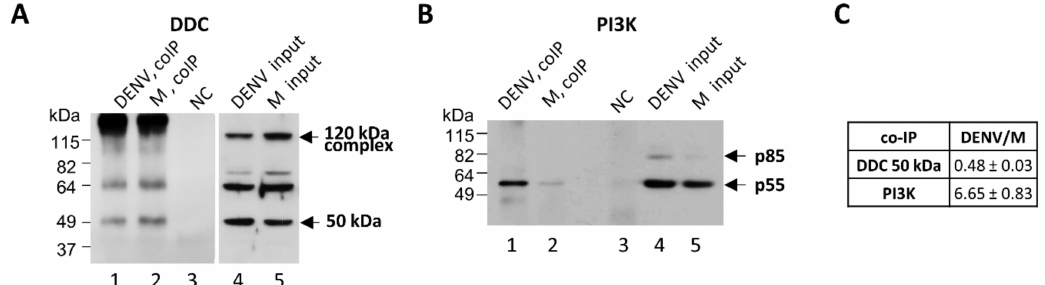
Figure 4. The influence of DENV infection on the DDC-PI3K complex. ( A – C ) Whole lysates of Huh7 DENV-infected cells (DV-2 16681, MOI = 1) at 48 h p.i were used in immunoprecipitation experiments, performed with anti-PI3K antibody. Western blot analysis was performed with anti-DDC-CT ( A ) or anti-PI3K ( B ) antibodies. Lysates from mock-infected cells were used as control. Lanes 1,2: Eluates